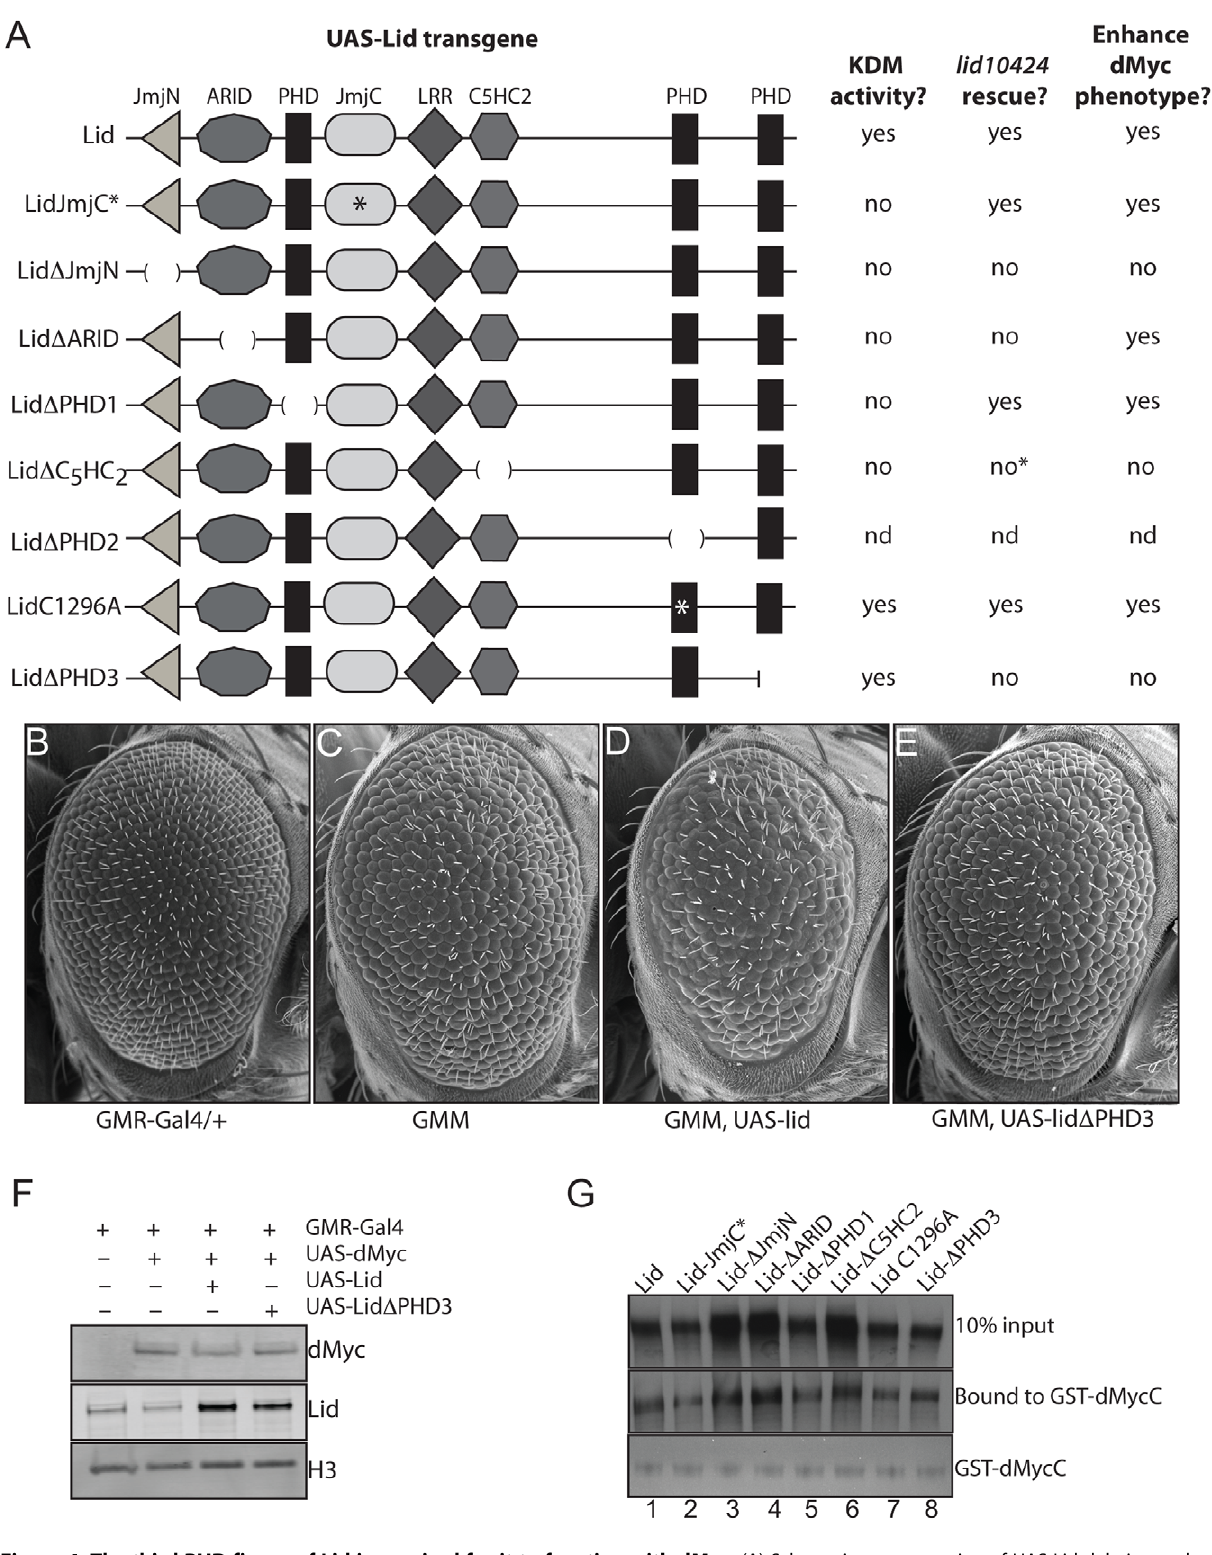
Figure 4. The third PHD finger of Lid is required for it to function with dMyc. (A) Schematic representation of UAS Lid deletion and point mutant transgenes (domains are not shown to scale) summarizing their histone demethylation activity, rescue of lid mutants ( lid 10424 ), and their ability to enhance the dMyc overexpression eye phenotype. (B–E) Scanning electron micrographs of GMR-Gal4 alone (B), GMR-Gal4, UAS-dMyc (3 copies of transgene; GMM) (C), GMM, UAS-Lid (D) and GMM, UAS-Lid D PHD3 (E). B through E all contain 3 copies of the UAS-dMyc transgene. (F) Western analysis of GMR-Gal4 alone (lane 1), GMM (lane 2), GMM, UAS-Lid (lane 3) and GMM, UAS-Lid D PHD3 (lane 4). (G) In vitro binding assays demonstrating that GST-dMyc binds full-length Lid, Lid-JmjC*, Lid D JmjN, Lid D ARID, Lid D PHD1, Lid D C5HC2, Lid C1296A and Lid D PHD3 (lanes 1–8, respectively). doi:10.1371/journal.pgen.1001221.g004 PLoS Genetics |